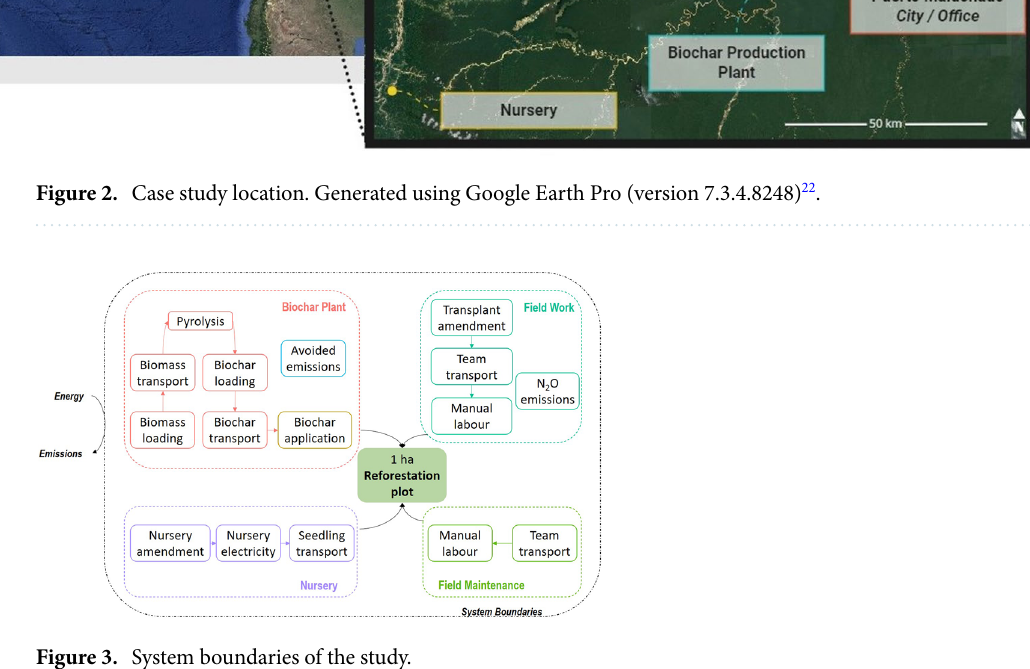
Figure 3. System boundaries of the